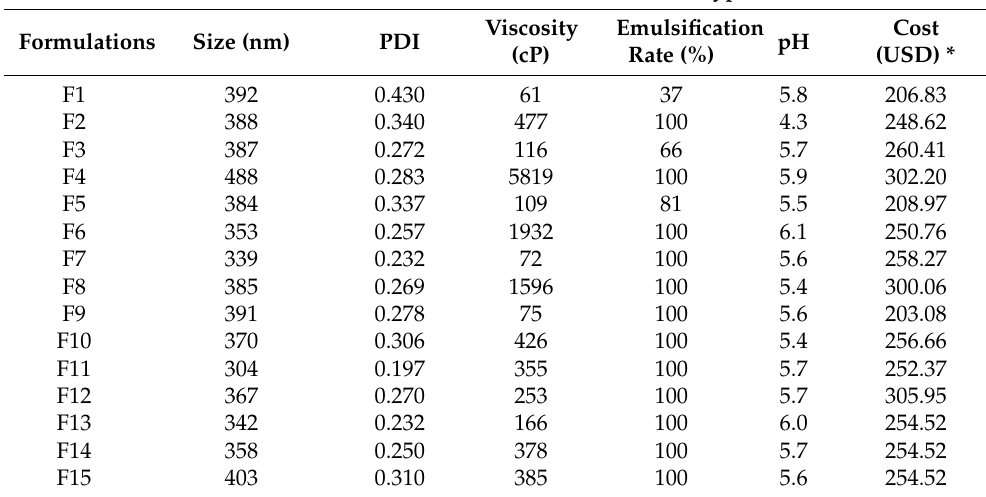
Table 3. Physicochemical characteristics and cost of Nano-2 prototypes as a function of independent variables (percentages of stabilizers H20, H100, and